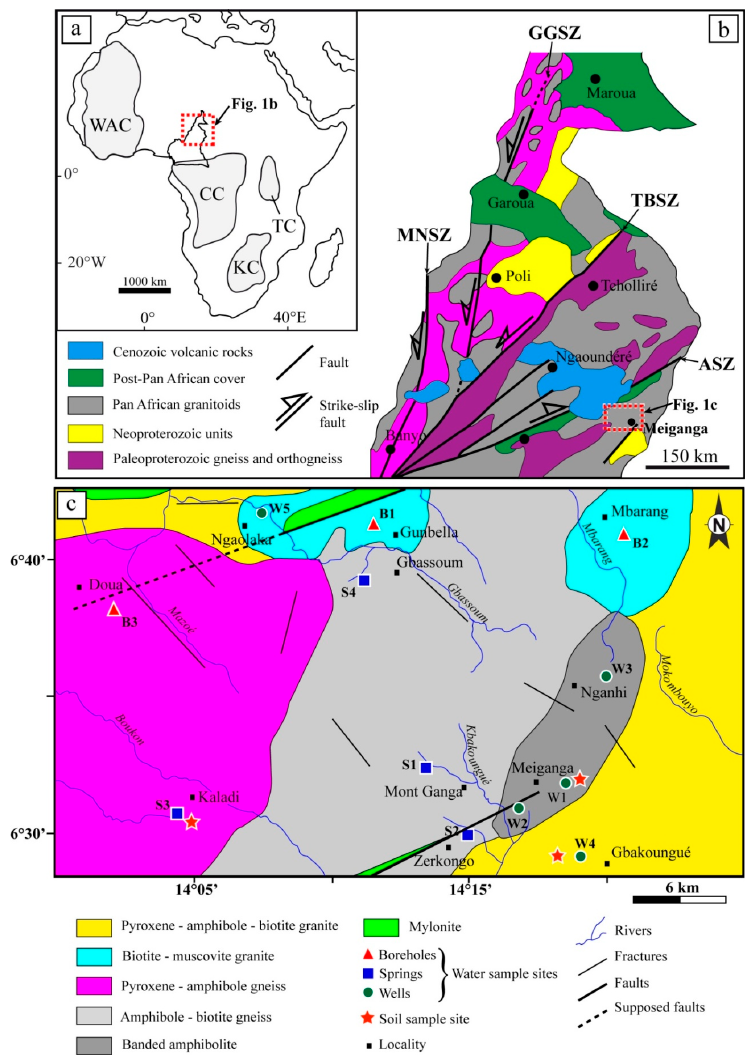
Figure 1. ( a ) Location of Cameroon in Africa, WAC: West African Craton; CC: Congo Craton; TC: Tanzanian Craton; KC: Kalahari Craton. ( b ) Geological sketch map of northern part of Cameroon showing from the major lithotectonic domains [17,23]; MNZ: Mayo Nolti shear zone; TBSZ: Tcholiré- Banyo Shear Zone; ASZ: Adamoua shear zone. ( c ) Geological map of the study area; modified from Ganwa et al. [18].